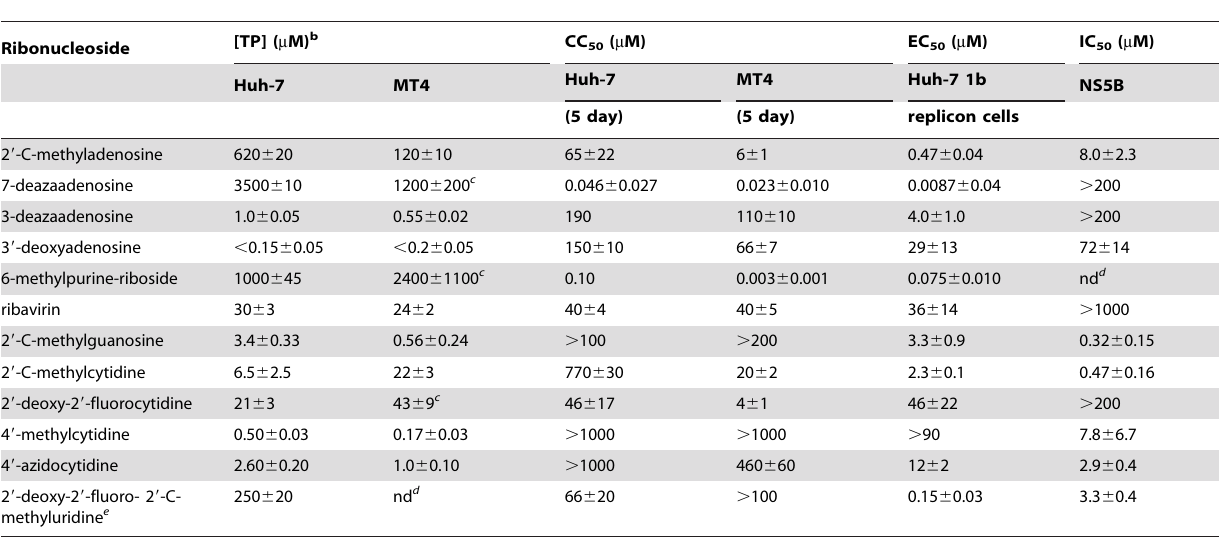
Table 1. Intracellular metabolism, cytotoxicity (CC 50 ), anti-HCV replicon activity (EC 50 ) and anti-NS5B activity (IC 50 ) a .